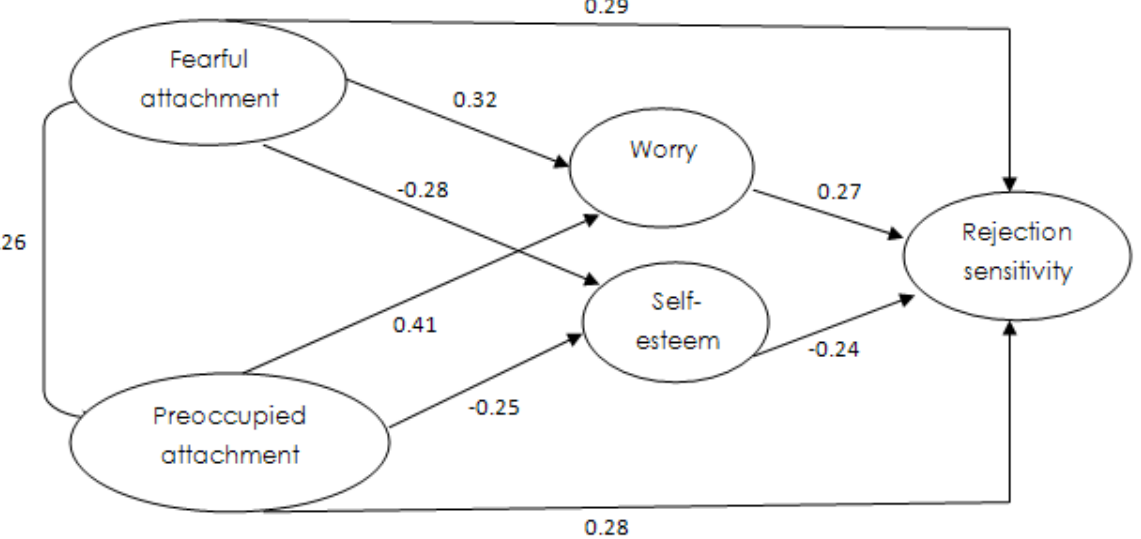
Figure 1. The structural equation model of Rejection Sensitivity. Standardized path coefficients are presented on each arrow.